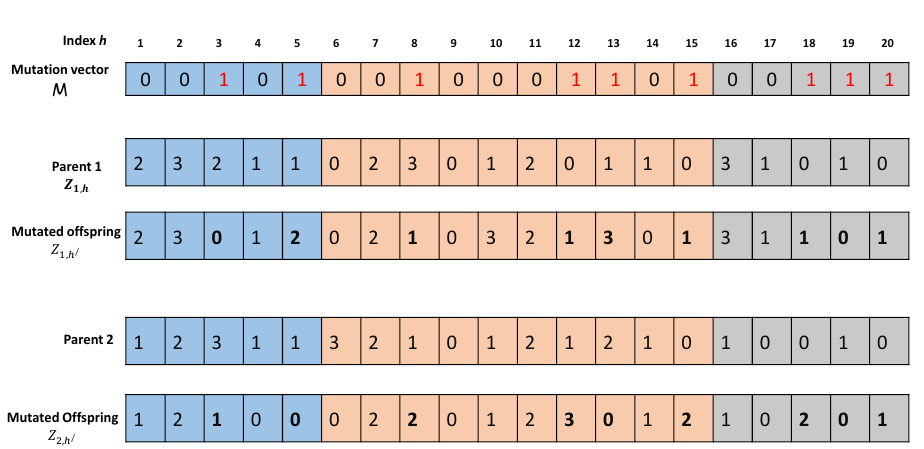
Figure 7. Knowledge-based crossover.